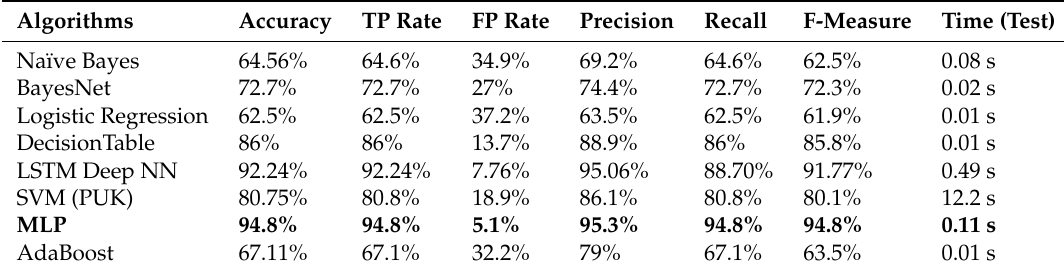
Table 6. Performance evaluation for attack scenario